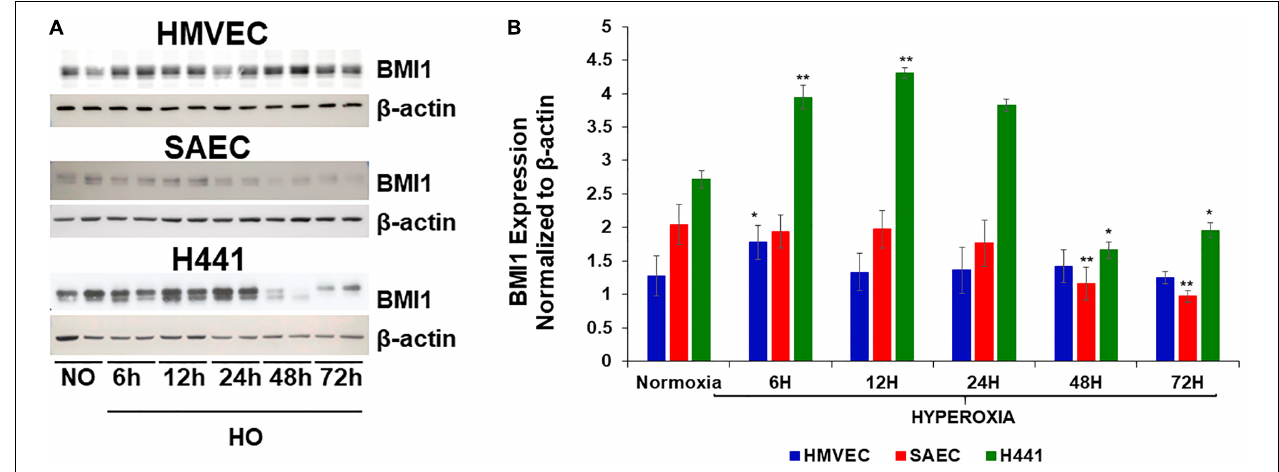
FIGURE 1 | BMI1 expression in three cell lines was evaluated at different time points of hyperoxia exposure. (A) Western blot of BMI1 expression after different time points of hyperoxia exposure. (B) Densitometric analysis of BMI1 expression after normalization to β -actin. n = 6 (mean ± SEM), one-way ANOVA, * p ≤ 0.05, ** p ≤